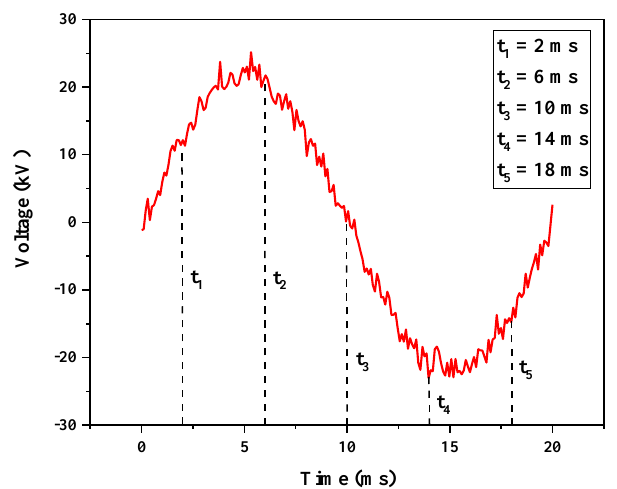
Figure 9. Applied HV voltage with the selected times for the presentation of the model results.